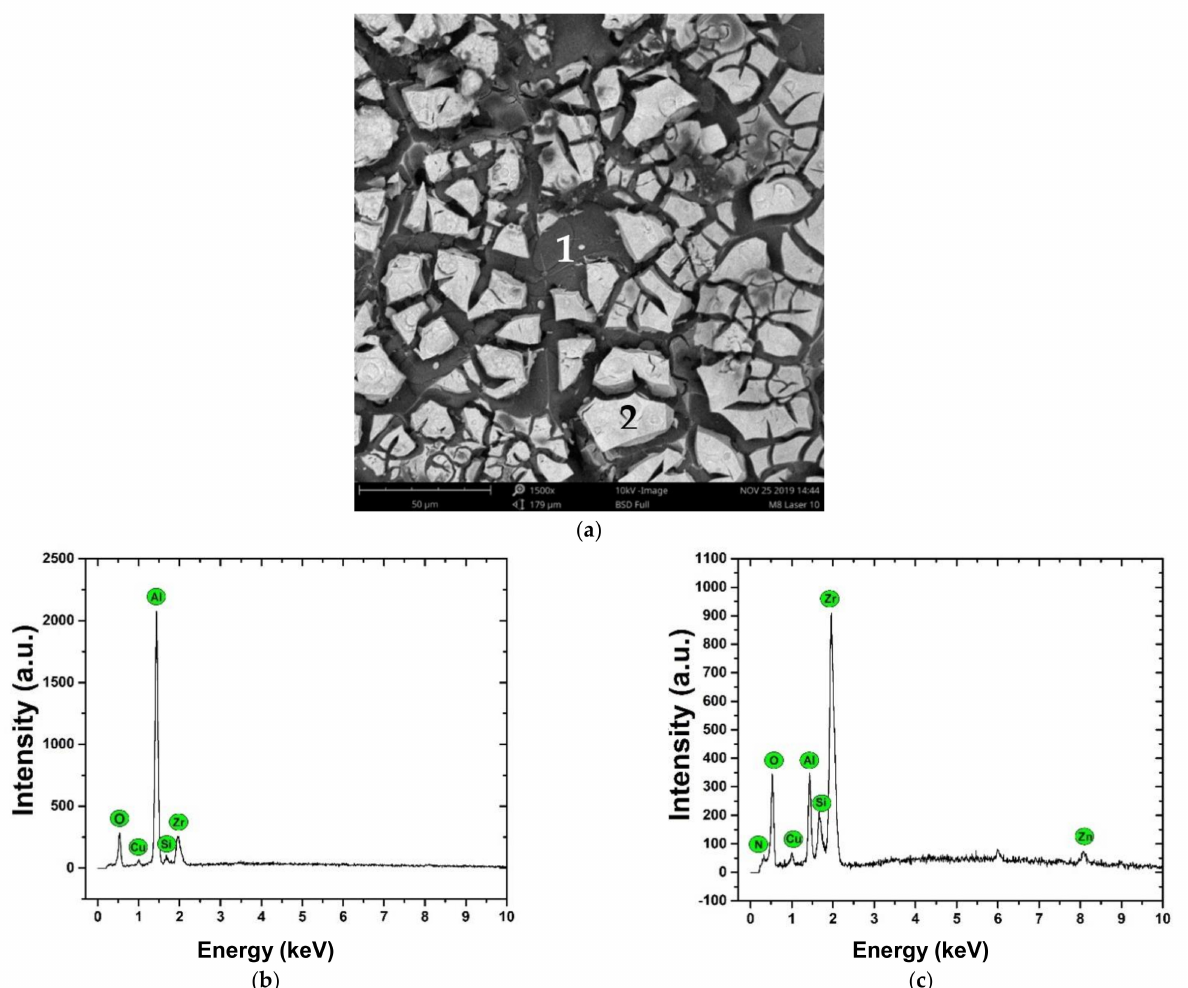
Figure 5. ( a ) SEM micrograph of the SSZ03 sample presenting position 1 and 2 for further EDS analysis, ( b , c ) EDS analysis over two different positions (1 and 2),